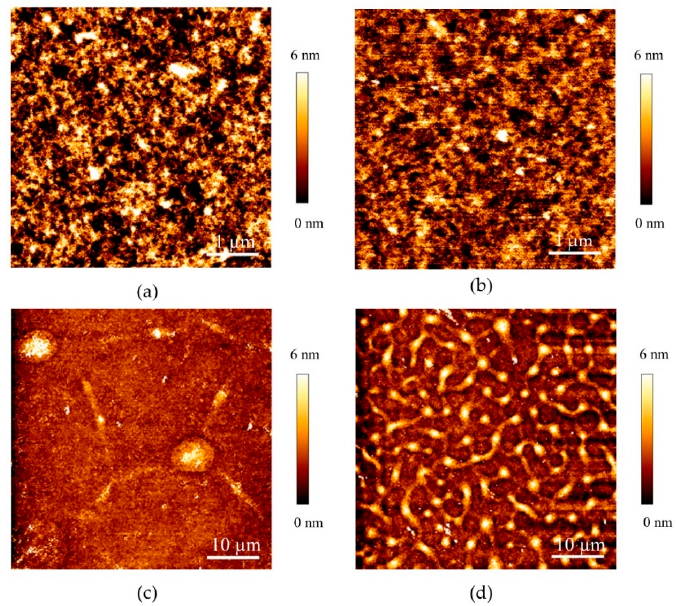
Figure 2. Atomic force microscopy topography images of peptide-PEG hydrogels and peptide-PEG coated glass surfaces. Surface topography of PEG-CLP ( a ), PEG-CLP-RGD ( b ) hydrogels and glass surfaces coated with the PEG-CLP ( c ) and PEG-CLP-RGD ( d ) conjugates. Images were acquired in PBS pH = 7.4 buffer solution.